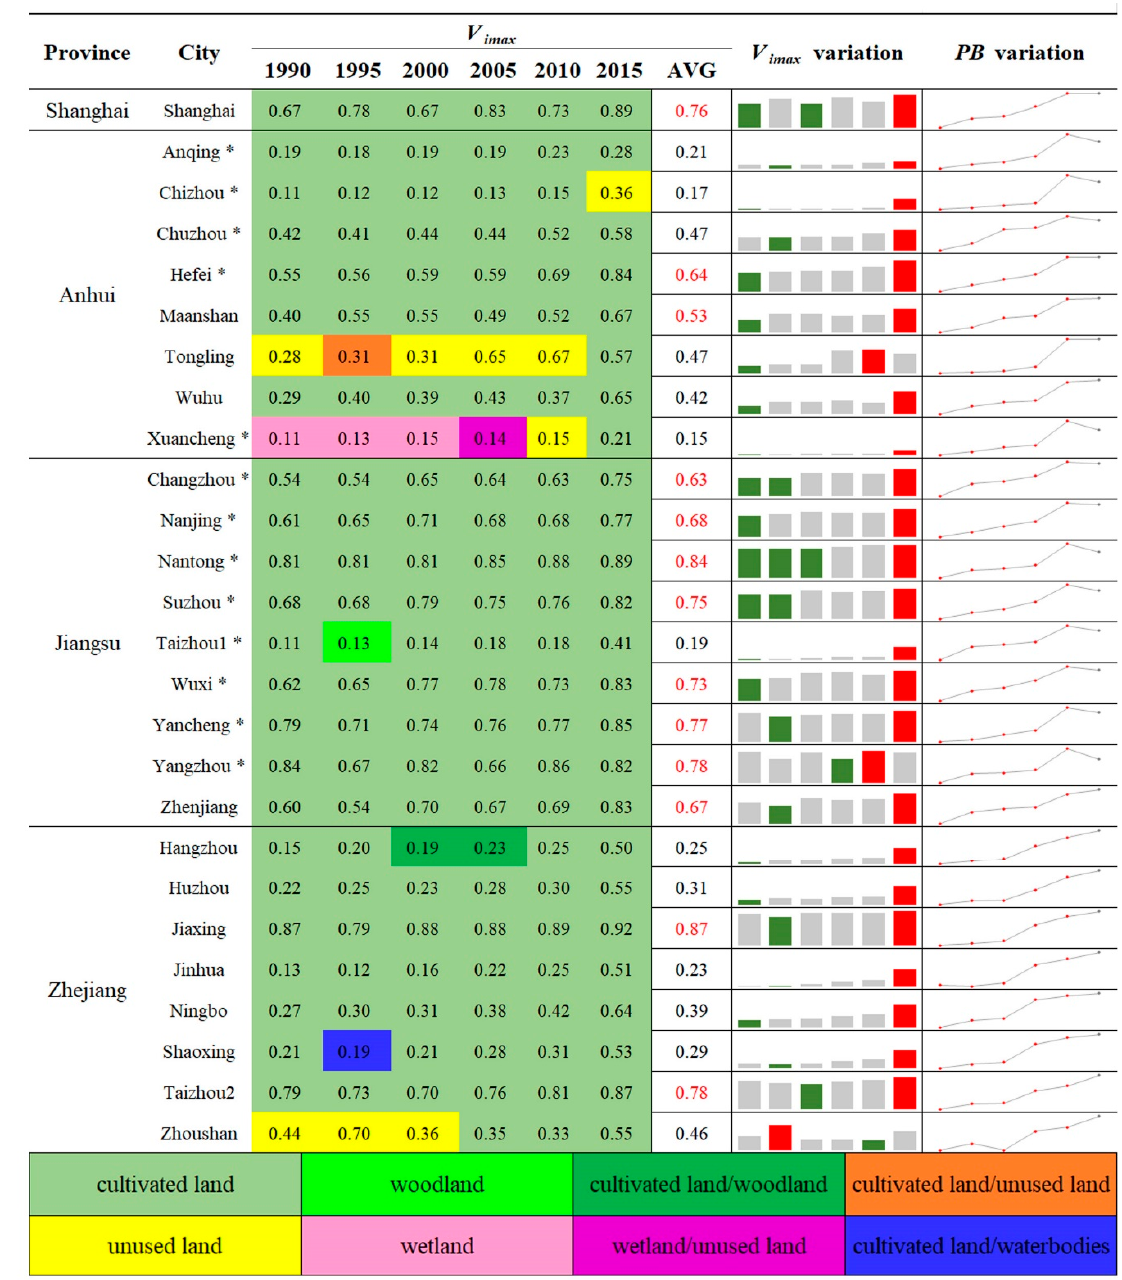
Figure 7. The maximum value of V i ( V imax ) and the corresponding natural landscape for each city in the YRD from 1990 to 2015. The asterisks in the second column denote the 12 cities where the total area of urban landscape decreased slightly in 2015 compared with that in 2010. AVG equals to the average of V imax for each city from 1990 to 2015. The bars in the V imax variation illustrate the corresponding maximum V i observed for each city from 1990 to 2015.The green and red bars represent the minimum and maximum values of V imax over these years, respectively. PB variation illustrated a changing trend in PB for each city over time.